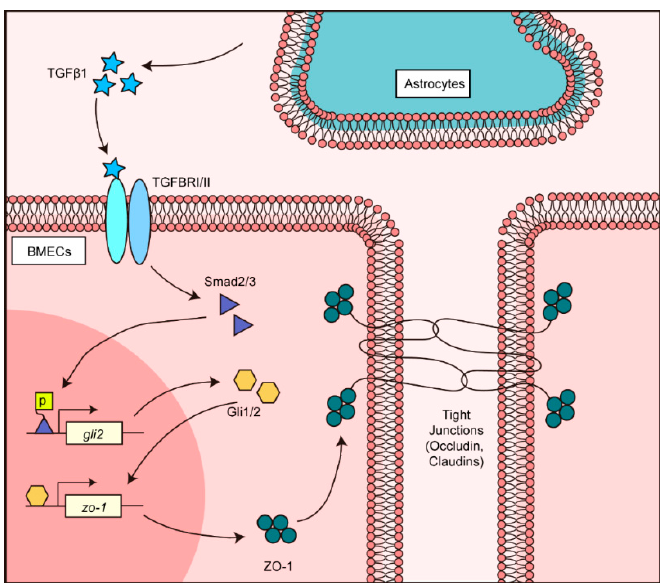
Figure 7. Schematic representation of the TGF β 1-mediated intercellular communication between astrocyte and BMECs in BBB. Astrocyte-derived TGF β 1 triggered the TGF β 1-TGFBRII-Smad2/3- Gli1/2-ZO-1 axis in BMECs and maintained the normal BBB function.